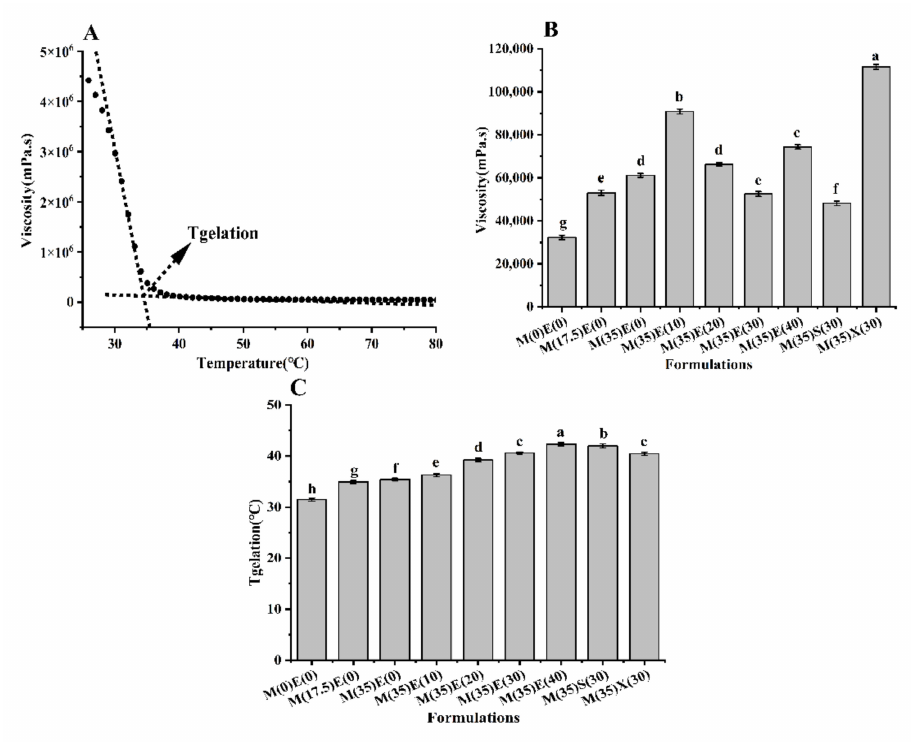
Figure 2. ( A ) Illustrative example of gelation temperature (Tgelation) for the composition M(17.5)E(0) with a cooling rate of 1 ◦ C/min. Tgelation was determined by extrapolating the high and low temperature asymptotes of the viscosity and specifying the temperature at which these intersect. ( B ) Viscosity of different gummy inks at 75 ◦ C. ( C ) Tgelation of inks with different polyol formulations. Different lowercase letters denote significant differences ( p <